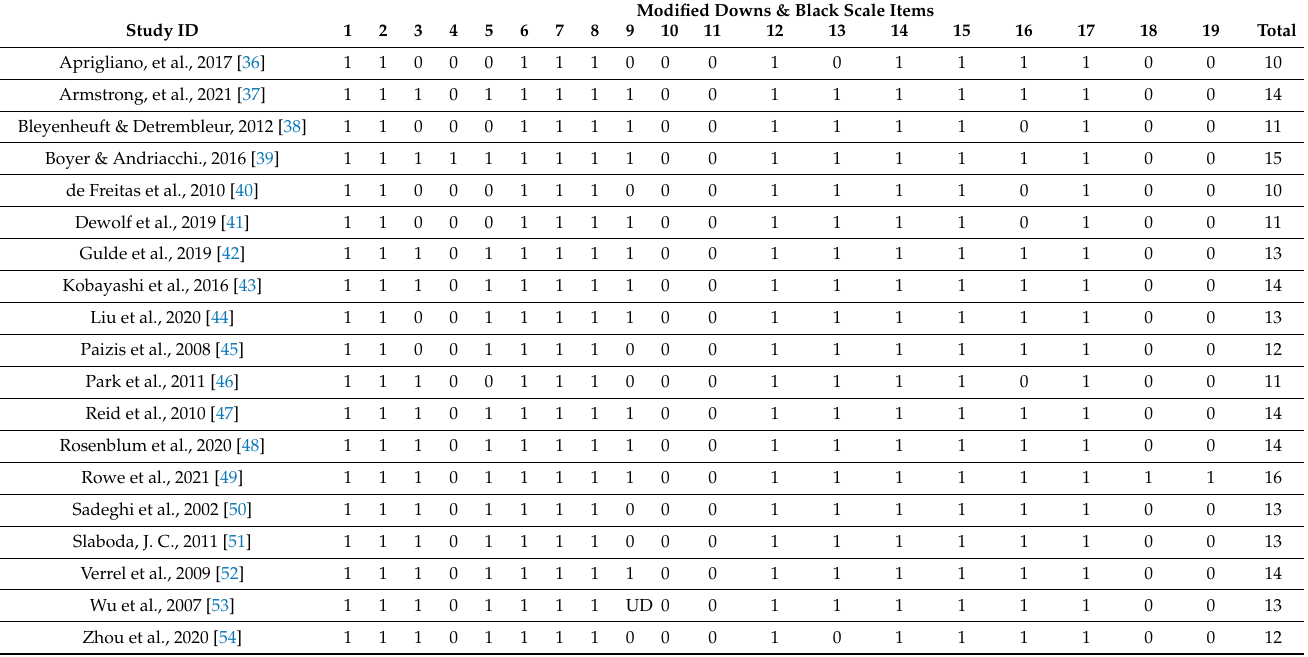
Table 4. Methodological quality assessment according to modified Downs & Black